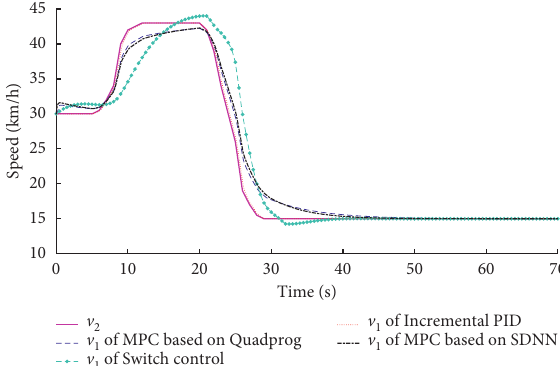
Figure 10: Speeds of the LV and the FV of four controllers.